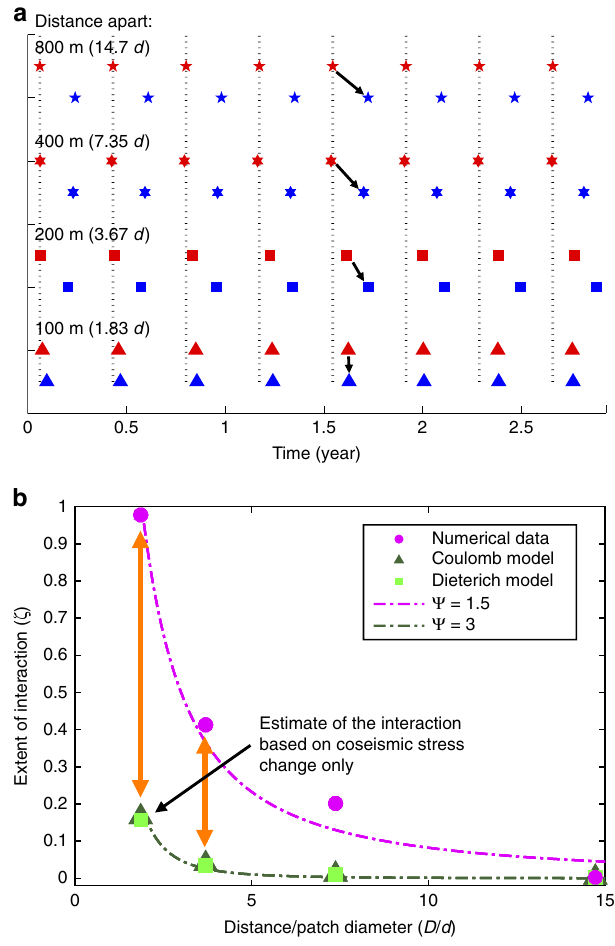
Figure 2 | Exploring the extent of interaction between the two repeating earthquake sequences. ( a ) Dependence of the interaction on the distance between the patches. Red and blue markers represent the occurrence of seismic events on the two VW patches. Patches in the simulation with D ¼ 15 d rupture with the expected interevent time of half of the single-patch recurrence time, and hence they are non-interacting. The inter-event times decrease significantly as the distance between the two VW patches reduces. Dashed lines mark the recurrence interval for the non-interacting case. ( b ) Extent of interaction in our simulations (circles) plotted against separation distance D / d . Estimates of the interaction based on the coseismic stress changes only for the Coulomb and Dieterich models are shown as triangles and squares, respectively. Orange arrows indicate the inferred effect of postseismic creep which clearly dominates. Dashed lines show the fit of the results to a power law z ¼ ( D / d ) (cid:2) C